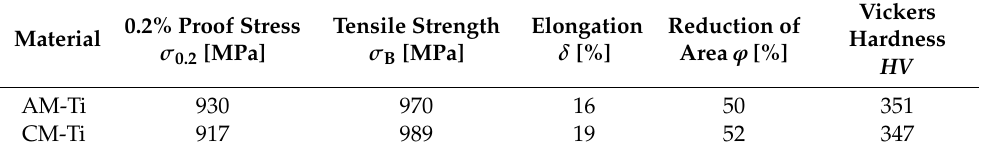
Table 1. Mechanical properties of